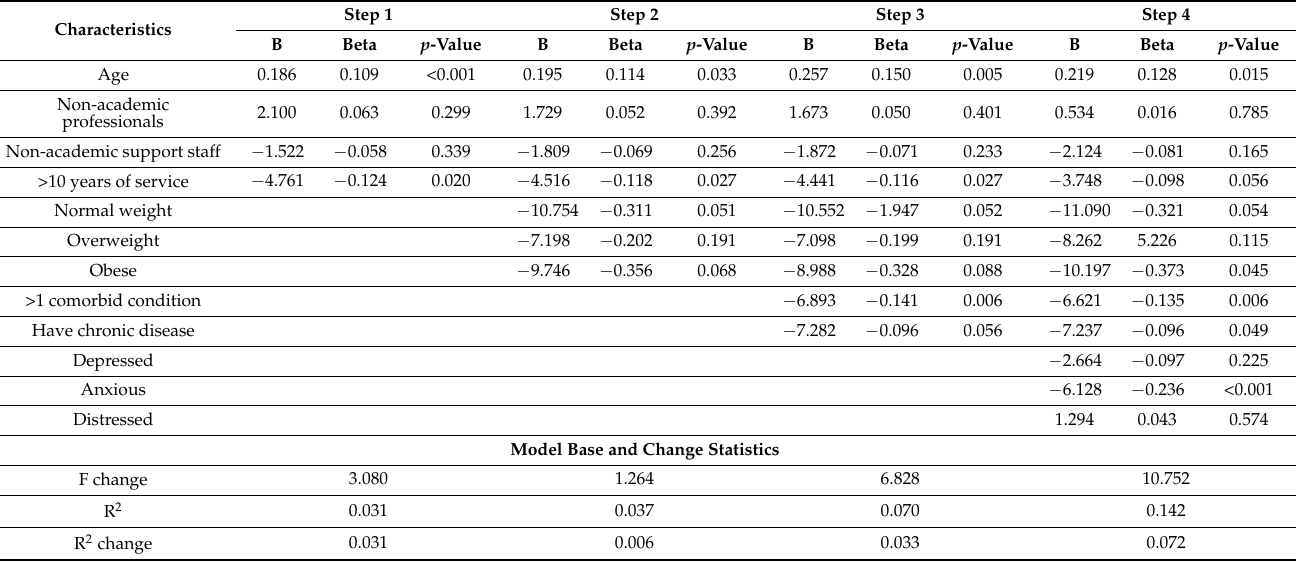
Table 4. Factors associated with the physical HRQoL according to the hierarchical multiple linear regression analysis.